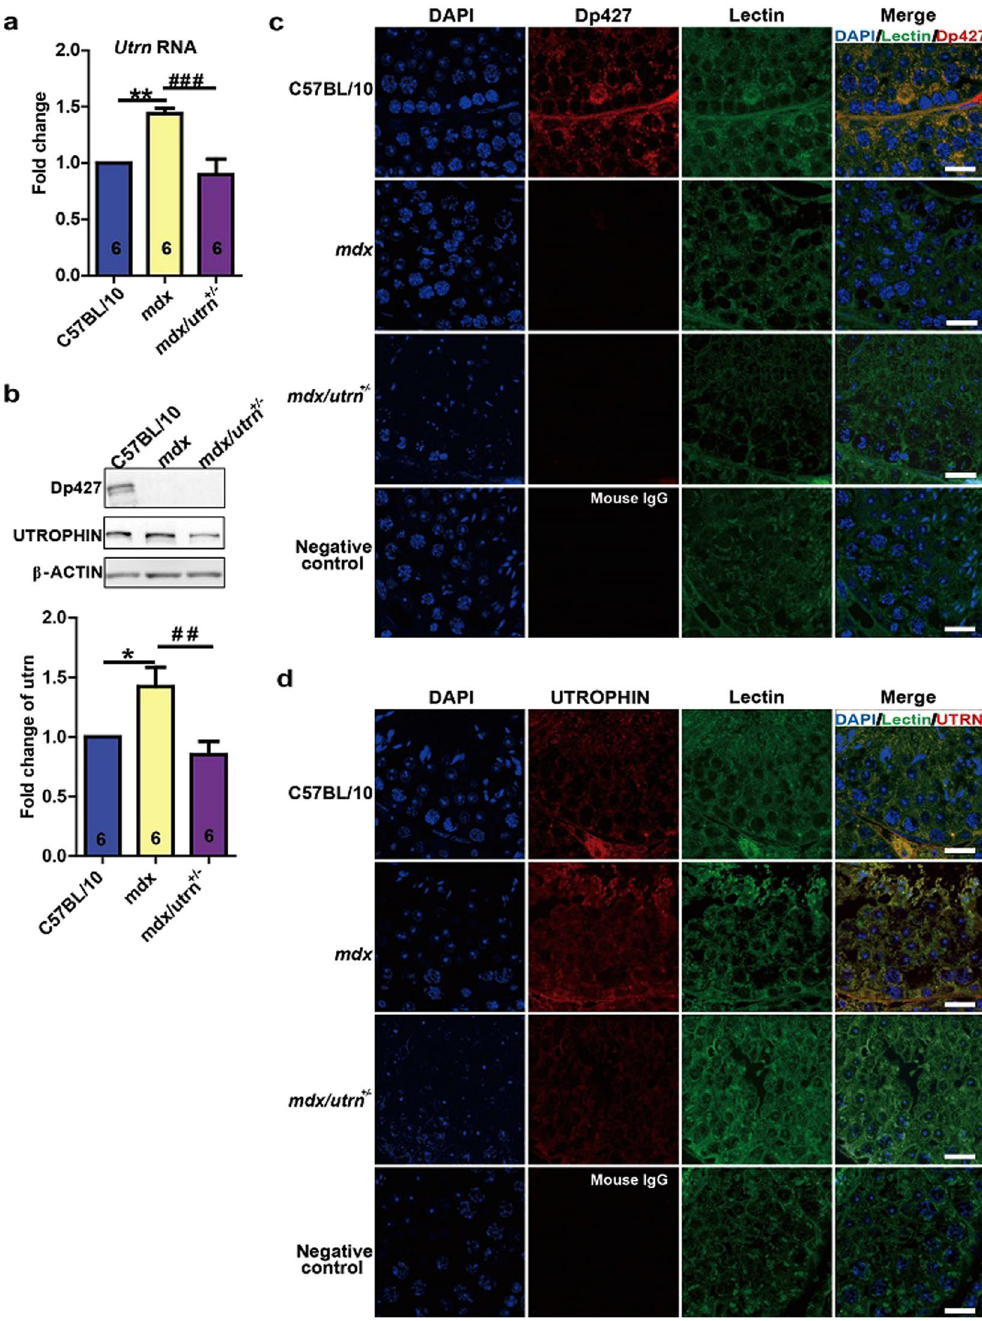
Figure 2. Dystrophin and utrophin express in the testes. Testes and epididymides of the ten-week-old mice were homogenized to isolate mRNA and protein for determining the expression of dystrophin and utrophin. ( a ) Quantitative PCR shows expression of utrophin in mice of all strains examined. ( b ) The upper panel shows the Western blotting for dystrophin and utrophin proteins in C57BL/10, mdx and mdx/utrn + / − testes. The lower panel shows the statistical analysis of the Western blotting for utrophin protein. The full blots of dystrophin and utrophin were provided in Supplementary Fig. S1a and b. ( c , d ) Cross-sections of the ten-week-old C57BL/10, mdx and mdx/utrn + / − testes were labeled with antibodies against dystrophin ( c ) and utrophin ( d ). The nuclei were tagged with DAPI and FITC-Lectin was used to outline the cells. utrn: utrophin. Scale bar: 20 μ m. Data were analyzed with one-way ANOVA, n = 6. All values are represented as mean ± SEM. * compared with the C57BL/10; # compared with the mdx . ## P < 0.01; ### P < 0.001; * P < 0.05; ** P <